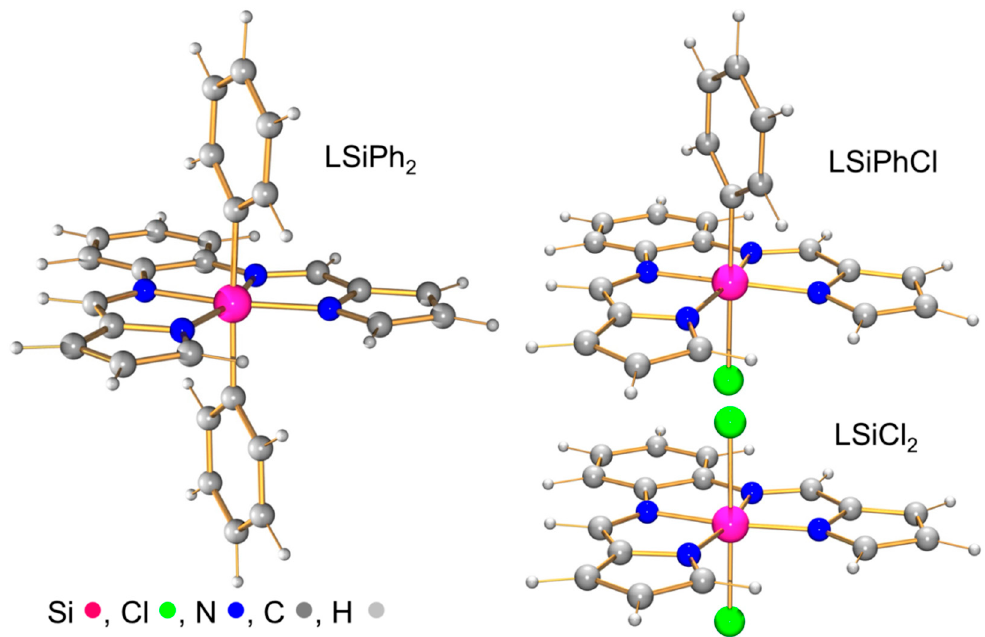
Figure 3. Molecular structures of LSiPh 2 , LSiPhCl and LSiCl 2 optimized at the MPW1PW91/6-311G(d,p) level.